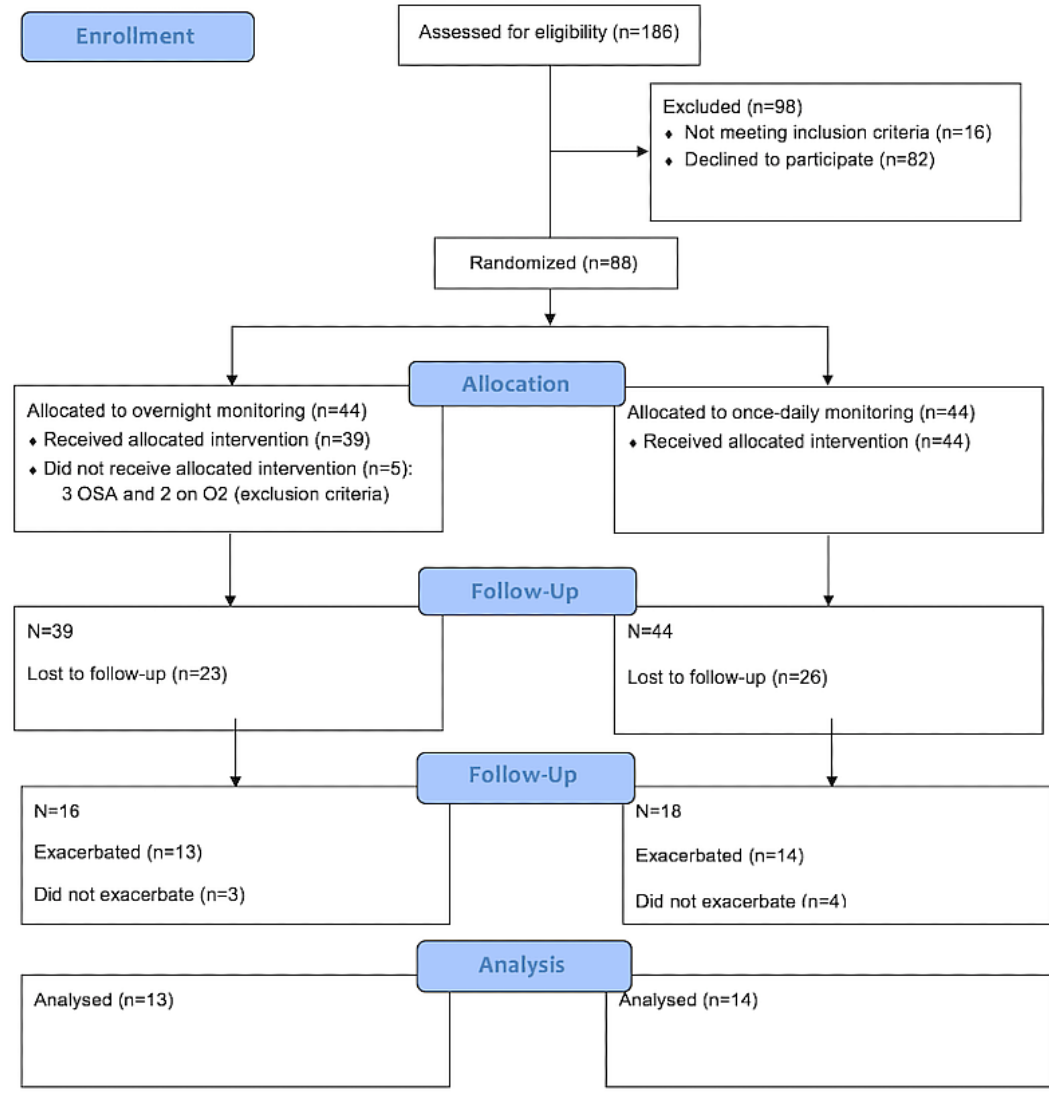
Figure 1. CONSORT (Consolidated Standards of Reporting Trials) flow diagram. OSA: obstructive sleep apnea; O 2 :